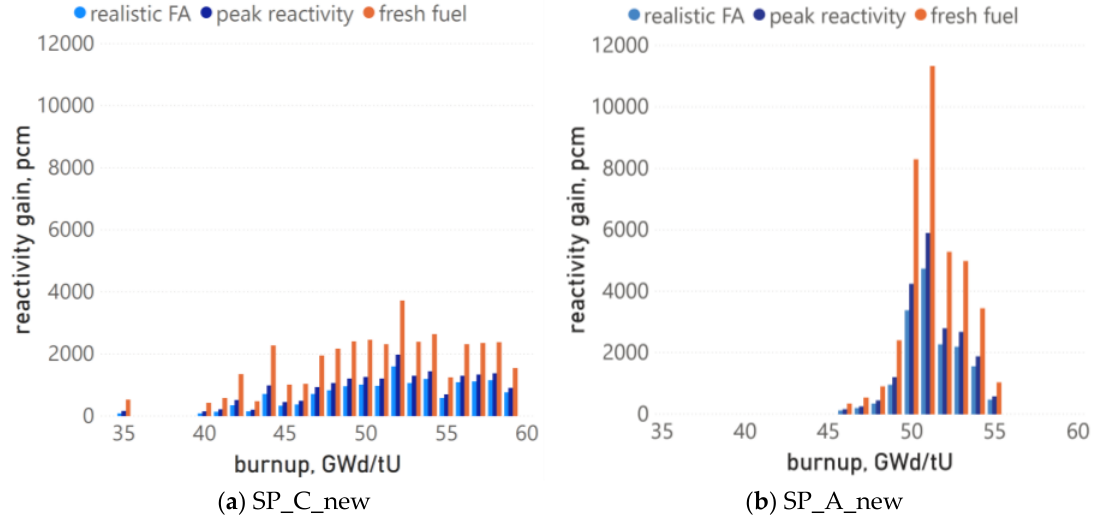
Figure 11. The normalised reactivity gain of the burnup credit (BUC) of the core approach in comparison with the fresh fuel, peak reactivity, and the peak reactivity of the realistic FA model approaches for BWR fuel for least optimal (a) SP_C_new and most optimal (b) SP_A_new burnup distributions. Table 7. The full core reactivity gain for the suggested BUC of the core approach in comparison with approximate ones.